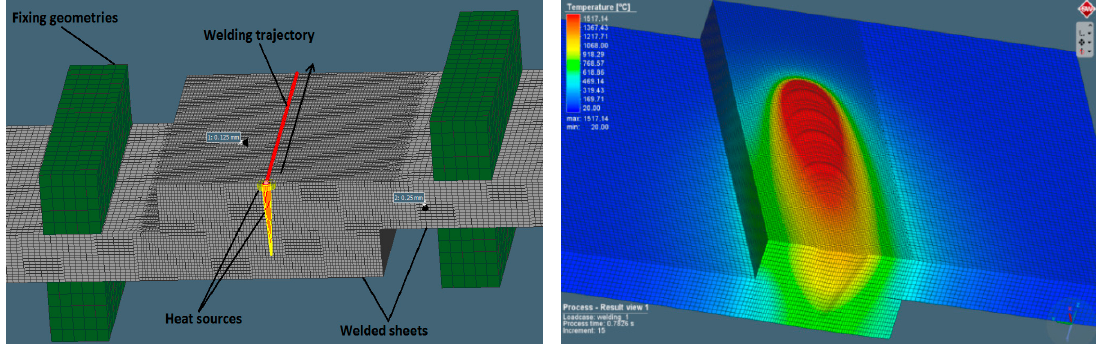
Figure 3. Laser-welding simulation model and the weld forming during the lap joint welding process.